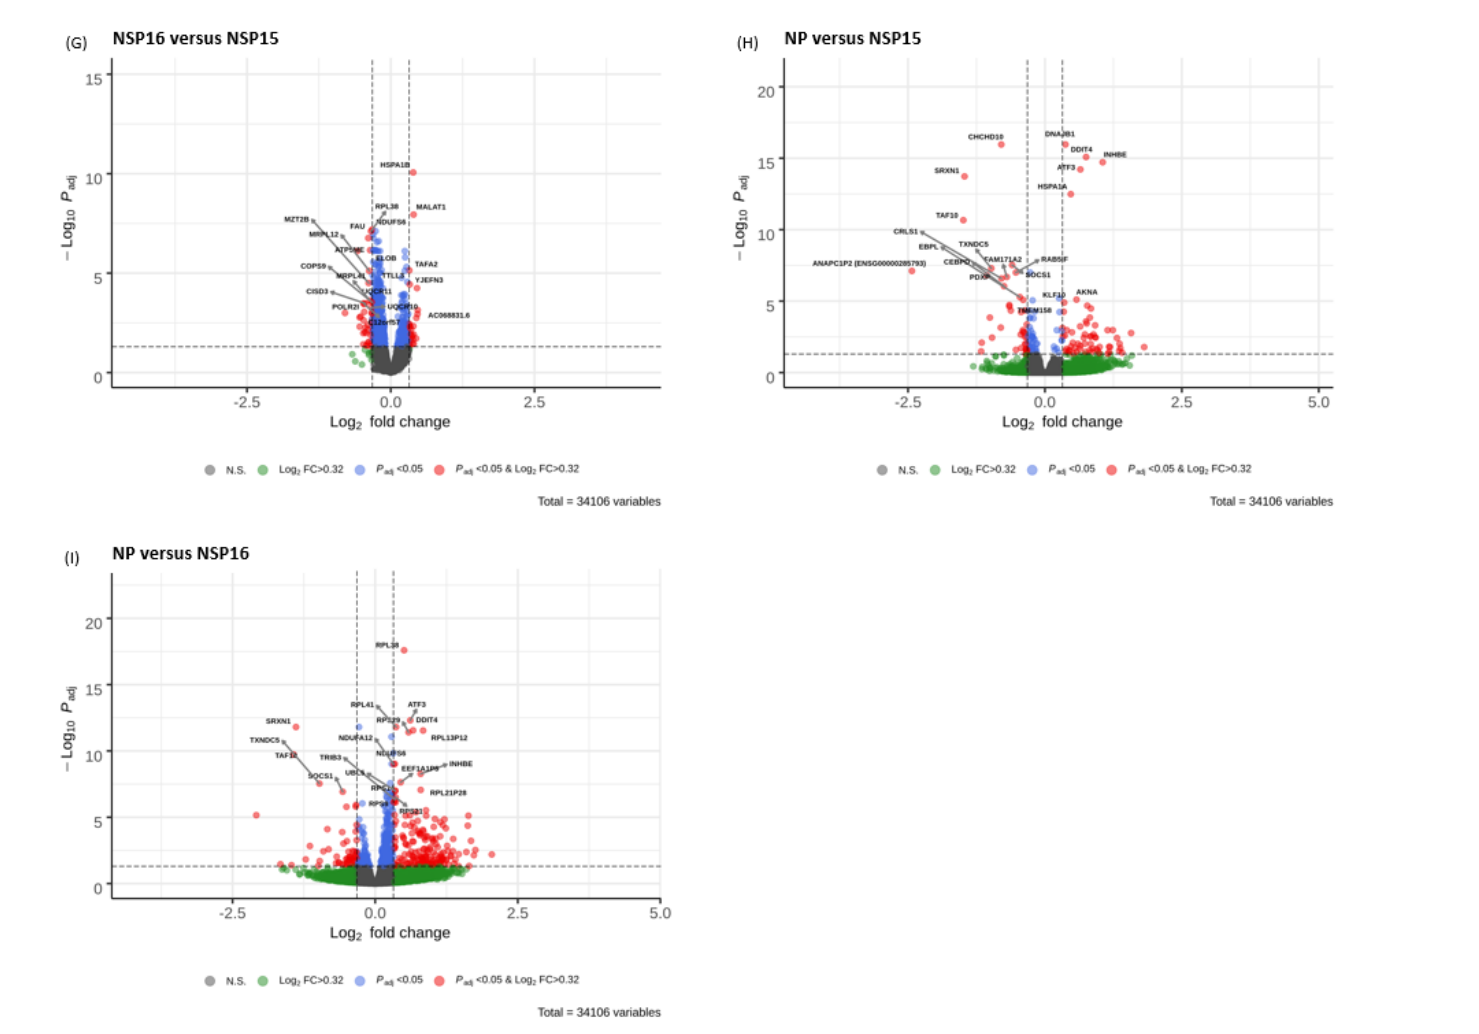
Figure 3. Volcano plots of the DEGs between transfections of ( A ) SARS-CoV-2 S1 versus PCMV vector control, ( B ) S2 versus PCMV, ( C ) S2 versus S1, ( D ) NSP15 versus PCMVF vector control, ( E ) NSP16 versus PCMVF, ( F ) NP versus PCMVF, ( G ) NSP16 versus NSP15, ( H ) NP versus NSP15, and ( I ) NP versus NSP16. Black dotted vertical lines highlight log 2 fold changes of > 0.32, while black dotted horizontal lines represent padj < 0.05. While DNAJB1, HSPA1A, HSPA1B, and HSPA6 were all significantly up-regulated in HL-CZ cells transfected with spike S1 and S2 subunits, the expression of the former three genes were significantly higher in the S2-transfected cells compared to those trans- fected with the S1 subunit (Table 3). On the other hand, HSPA6 expression was signifi- cantly higher in the S1-expressing cells than in the S2-expressing cells. Table 3. Average log 2 fold change of selected human genes of interest across RNA samples of HL-CZ cells expressing different SARS-CoV-2 genes (versus plasmid vector controls). Log 2 Fold Change (Adjusted p -Value) Gene